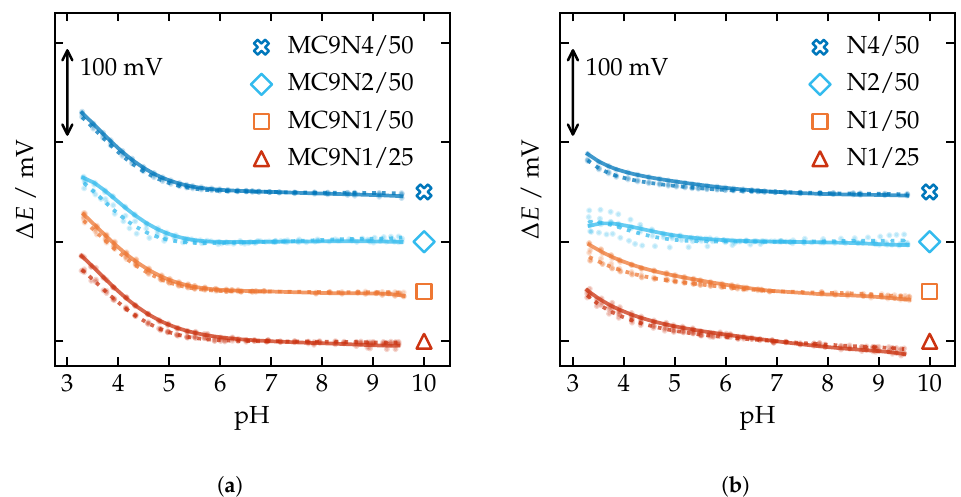
Figure A7. pH sensitivity of ( a ) sensors incorporating MC9 and ( b ) control sensors. The membranes were all plasticized with o -NPOE. Polynomials ( n = 7) fitted to the results of PVC- and PCTFE-shelled sensors are shown as solid and dotted lines, respectively. Measurements were performed in 10 − 2 M acetic acid titrated with a mixture of 0.25M NaOH and 10 − 2 M sodium acetate. See Table 1 for membrane compositions.